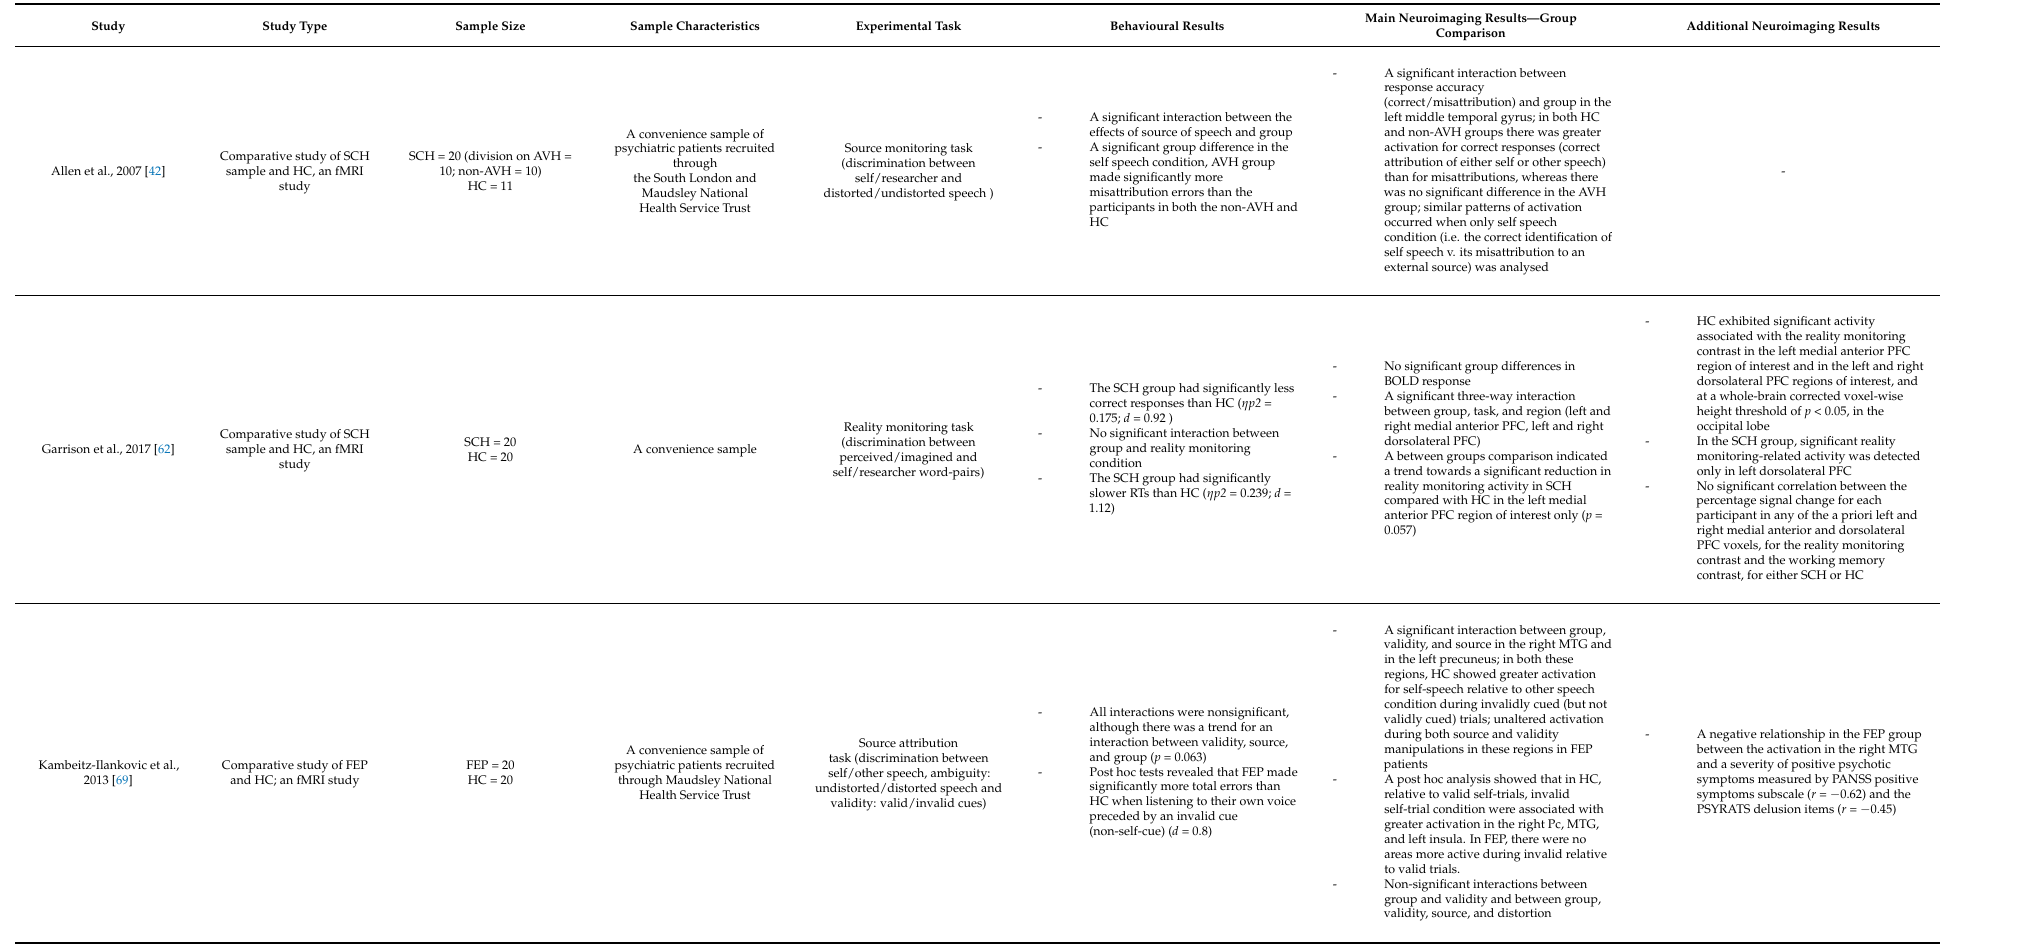
Table 2. Studies on source